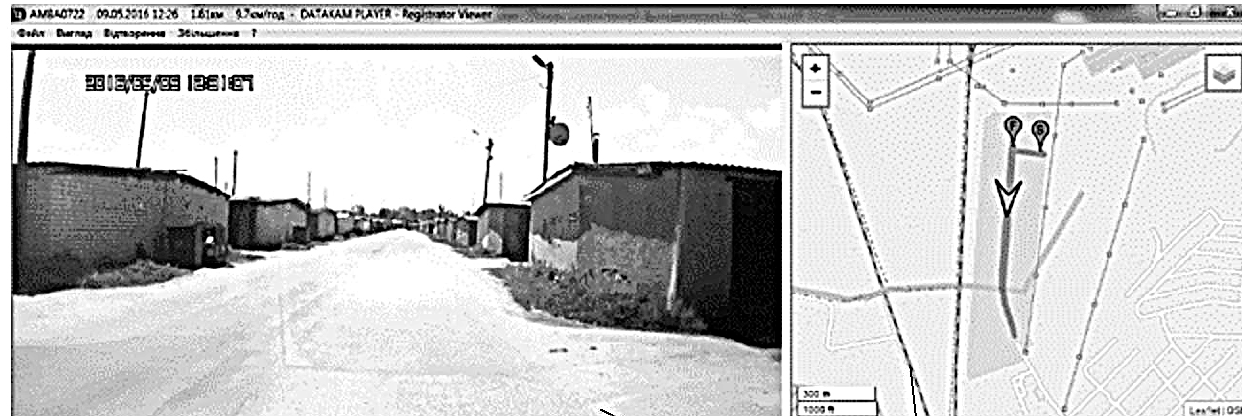
Figure 5. Example of the RegistratorViewer software package operation for traffic